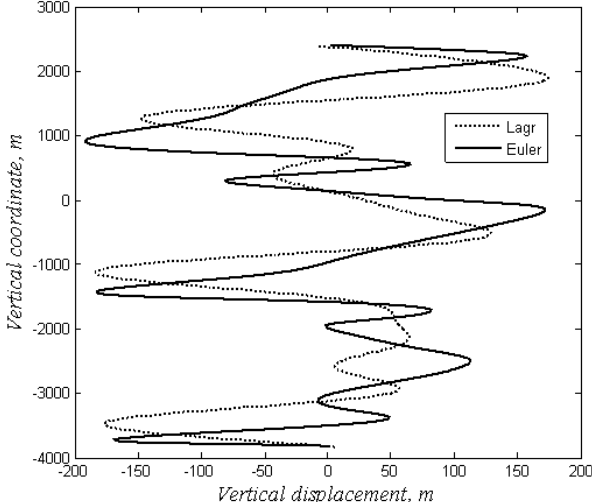
Fig. 2. Vertical profiles of the Eulerian and Lagrangian vertical dis- placement fields, L(c) ( a = 0 ) and E(z)(x 0 = 0 ) , in the case of non- resonant interactions between waves calculated for M 0 = 0 . 44m, ν V = 98m and t 0 = 2 . 5 × 10 3